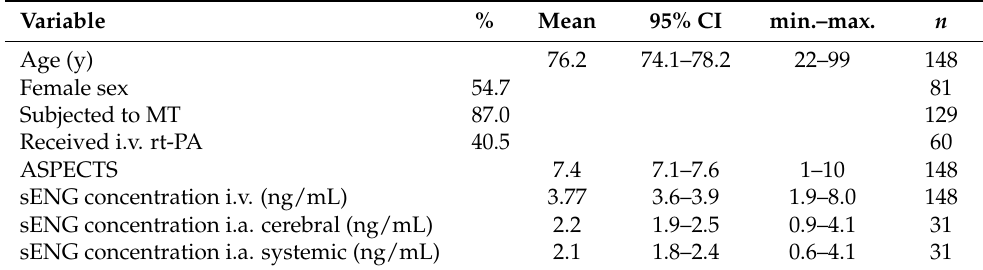
Table 1. Demographic, clinical and laboratory characteristics of the patients ( n =